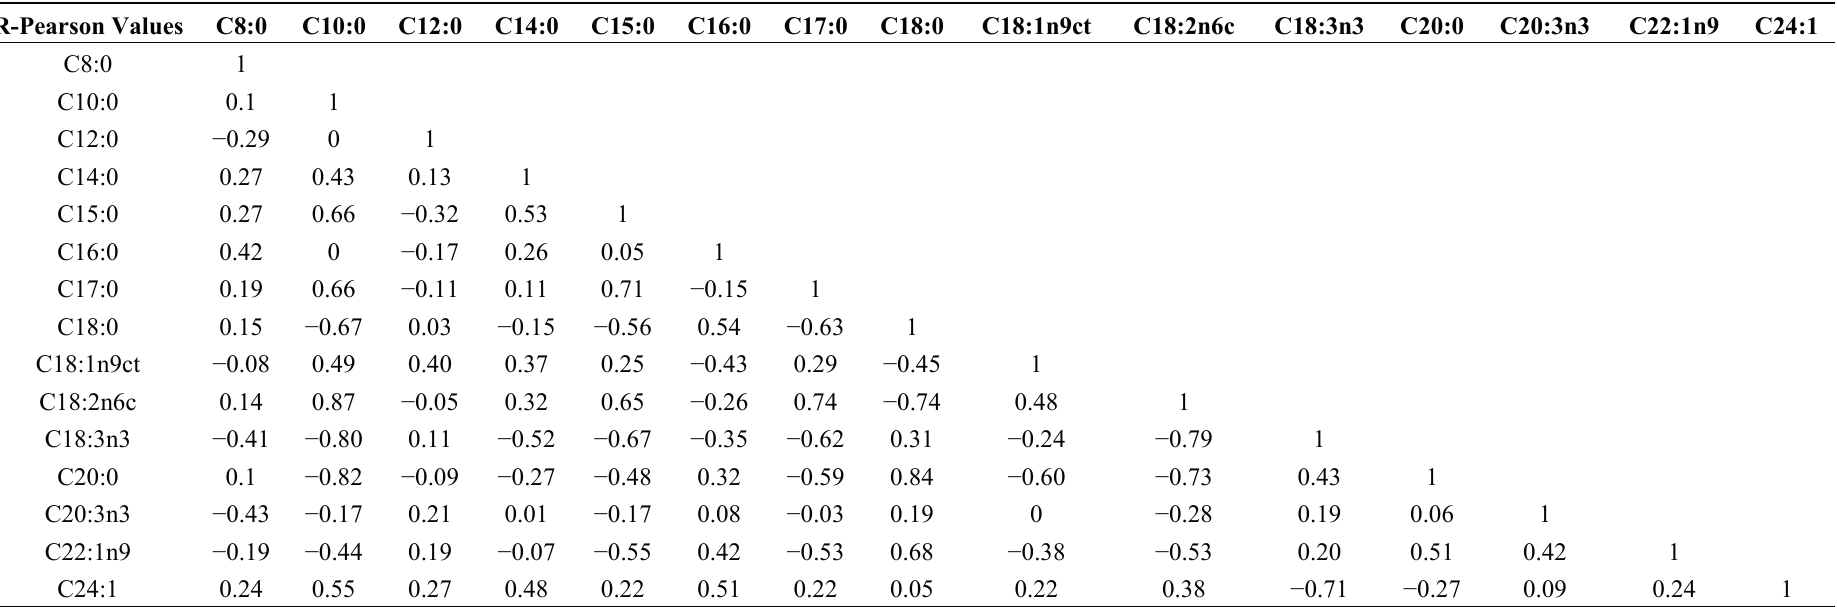
Table 3. Correlation matrix for the fatty acids using Pearson’s correlation